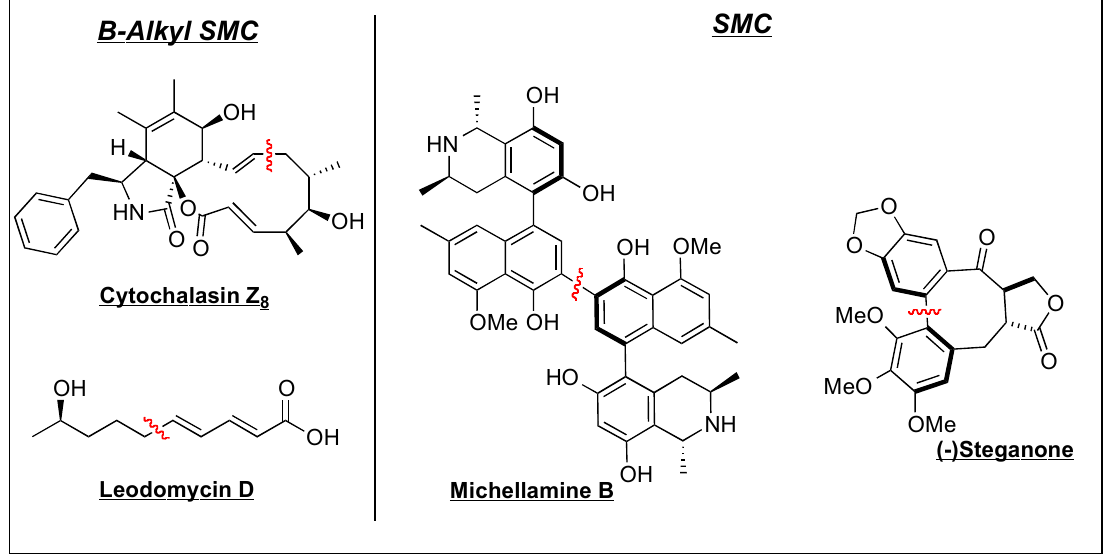
Scheme 16. Examples of drugs and active molecules whose total synthesis involved SMC.